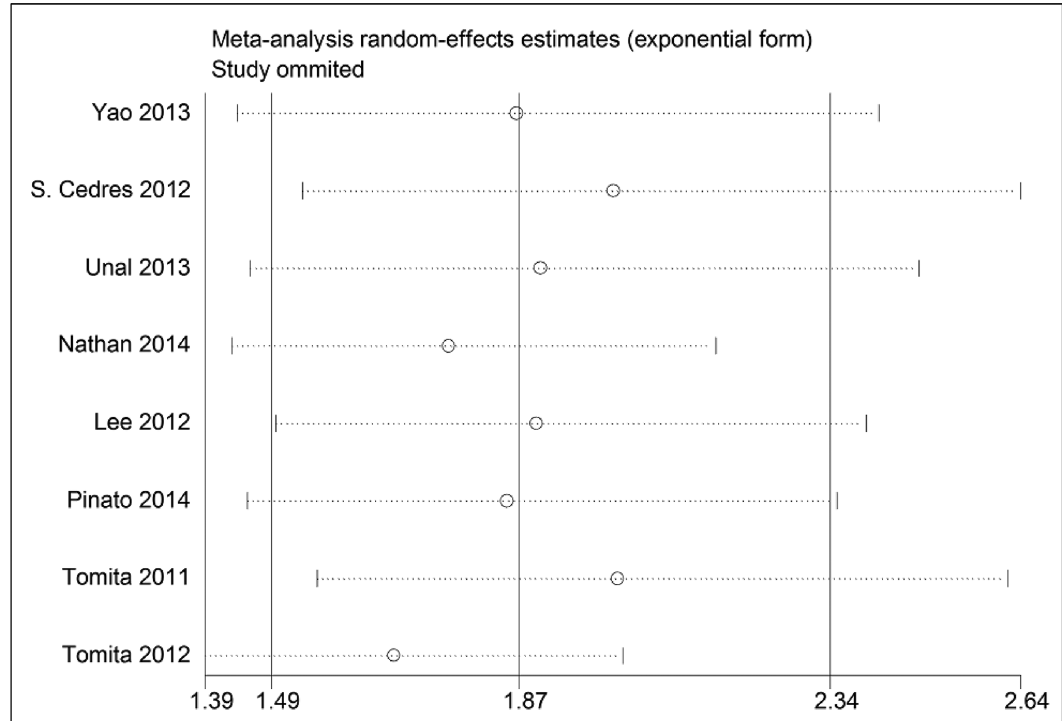
Figure 3 - Effect of univariate studies on the pooled HR for the NLR and OS of patients.